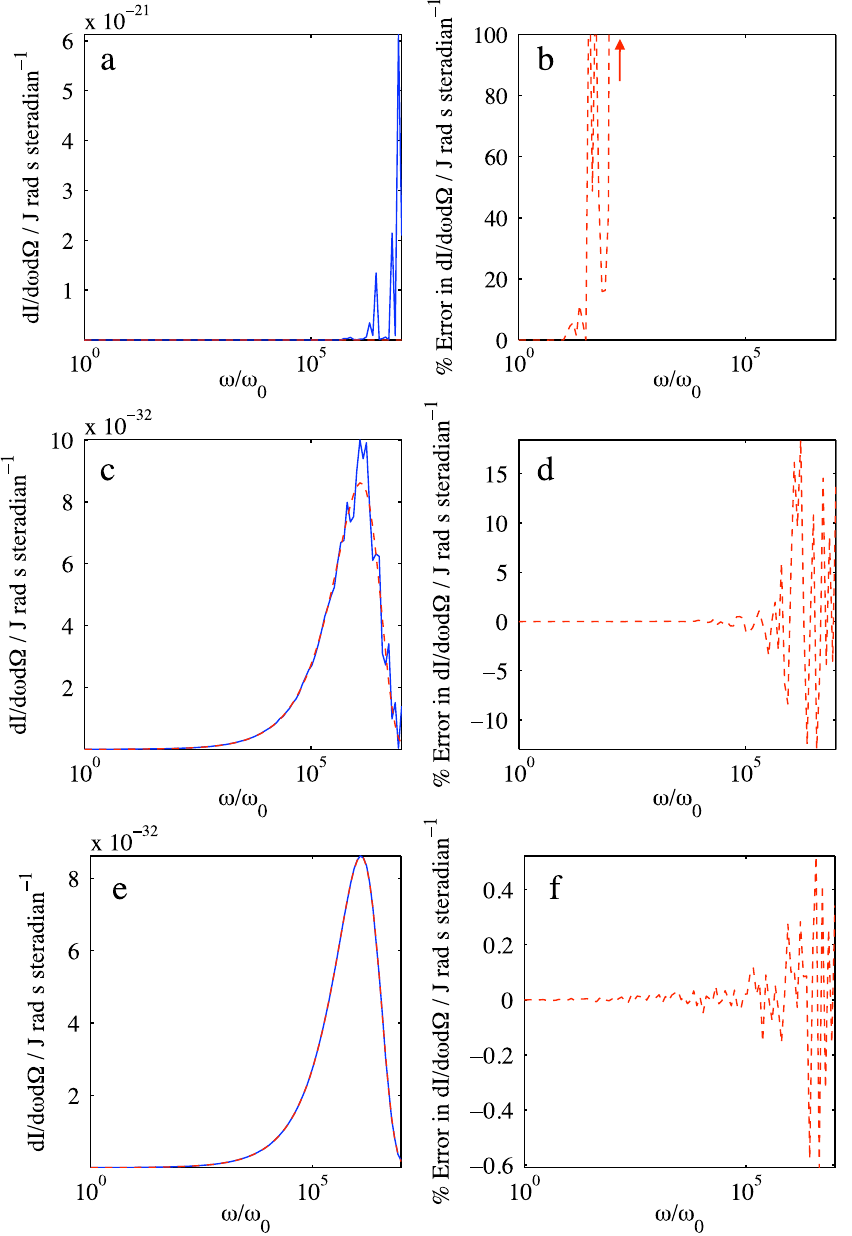
FIG. 2. (Color) Calculated synchrotron spectra (left) and the percentage error relative to the analytic solution (right) for different numerical integration techniques. The electron Lorentz factor is (cid:10) ¼ 1000 , and the magnetic field strength, B 0 , is such that =m ! 1 . The time step is ! (cid:2) (cid:4) ¼ (cid:3) (cid:2) 10 (cid:1) 4 . (a) and (b) Calculated spectrum and error for finite differenced numerical eB 0 e 0 ¼ 0 integration. (c) and (d) Calculated spectrum and error for summation of exact integrals using first-order interpolation of position. (e) and (f) Calculated spectrum and error for summation of exact integrals using second-order interpolation of position. In the left-hand images, the red dashed line corresponds to the analytic solution, and the blue solid line corresponds to the numerically calculated